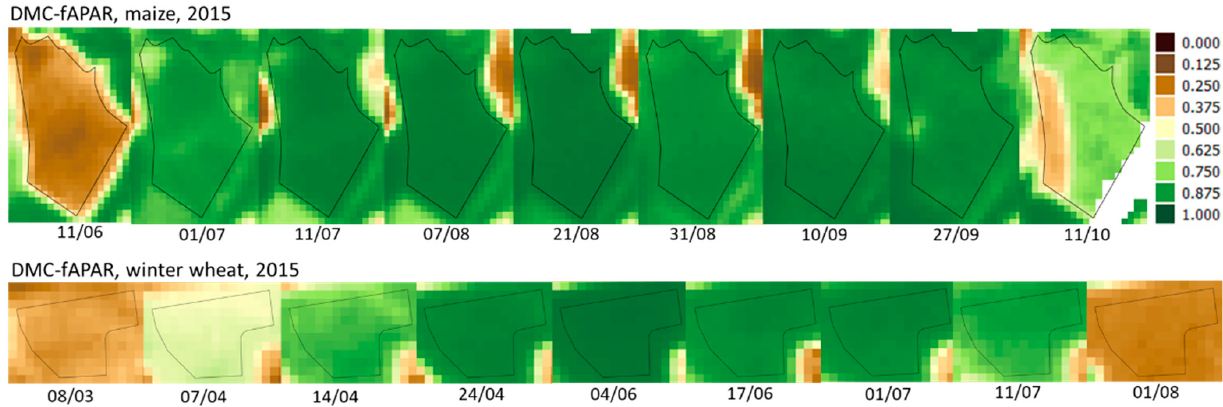
Figure 8. DMC-derived fAPAR progression for maize and winter wheat fields during 2015, including day/month of image acquisition.